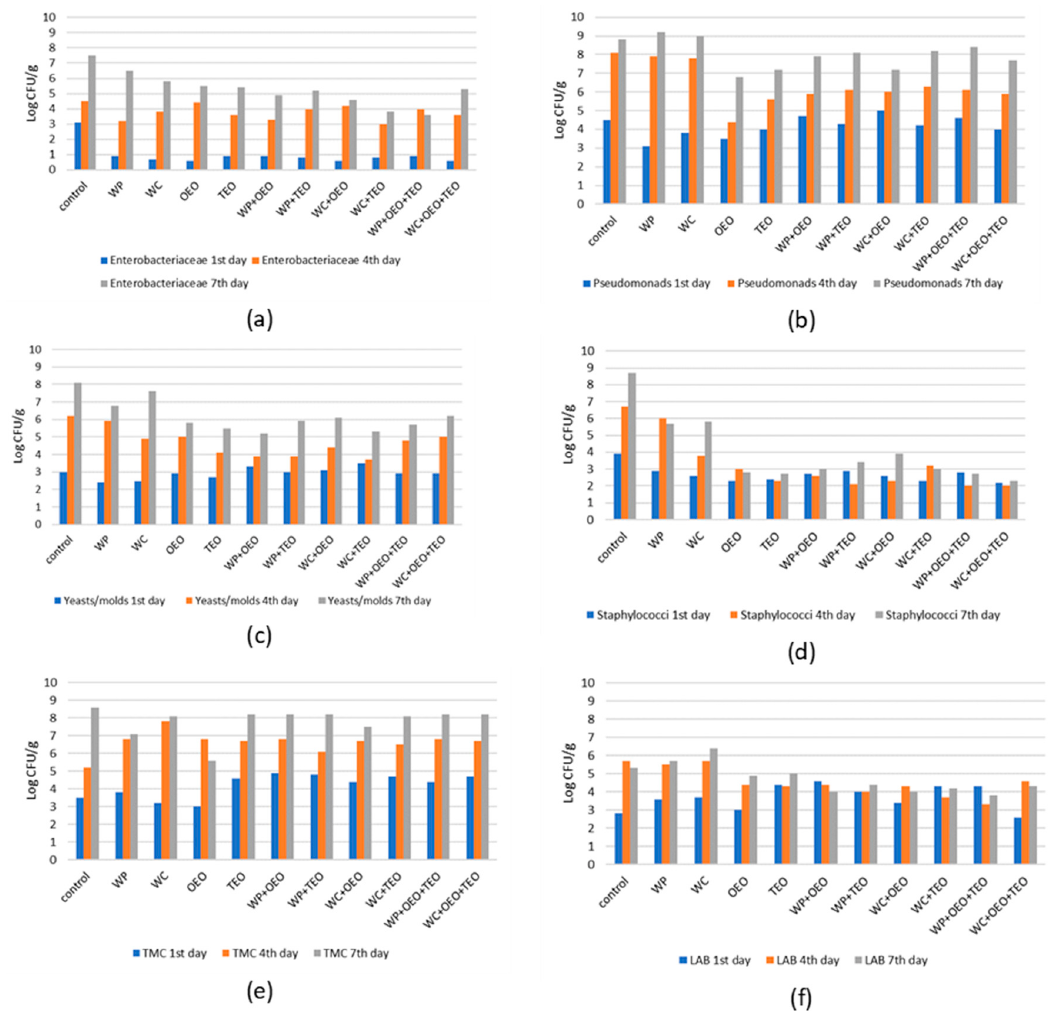
Figure 1. Total counts of ( a ) Enterobacteriaceae , ( b ) Pseudomonas spp., ( c ) yeasts and molds, ( d ) Staphylococcus spp., ( e ) total mesophilic counts (TMCs), and ( f ) LAB detected on meatballs after 1, 4 and 7 days of storage at 4 °C.